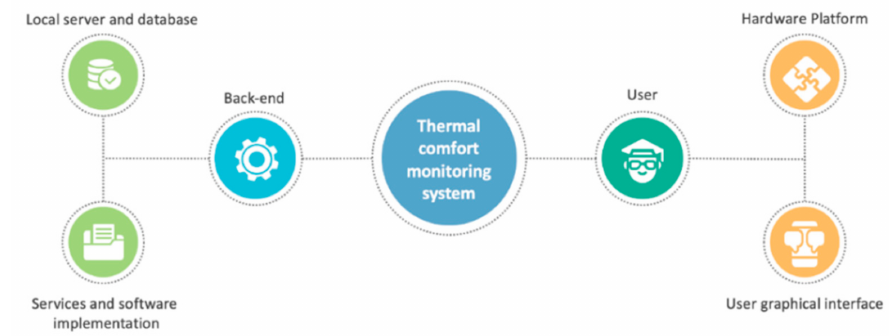
Figure 1. Overview of the developed